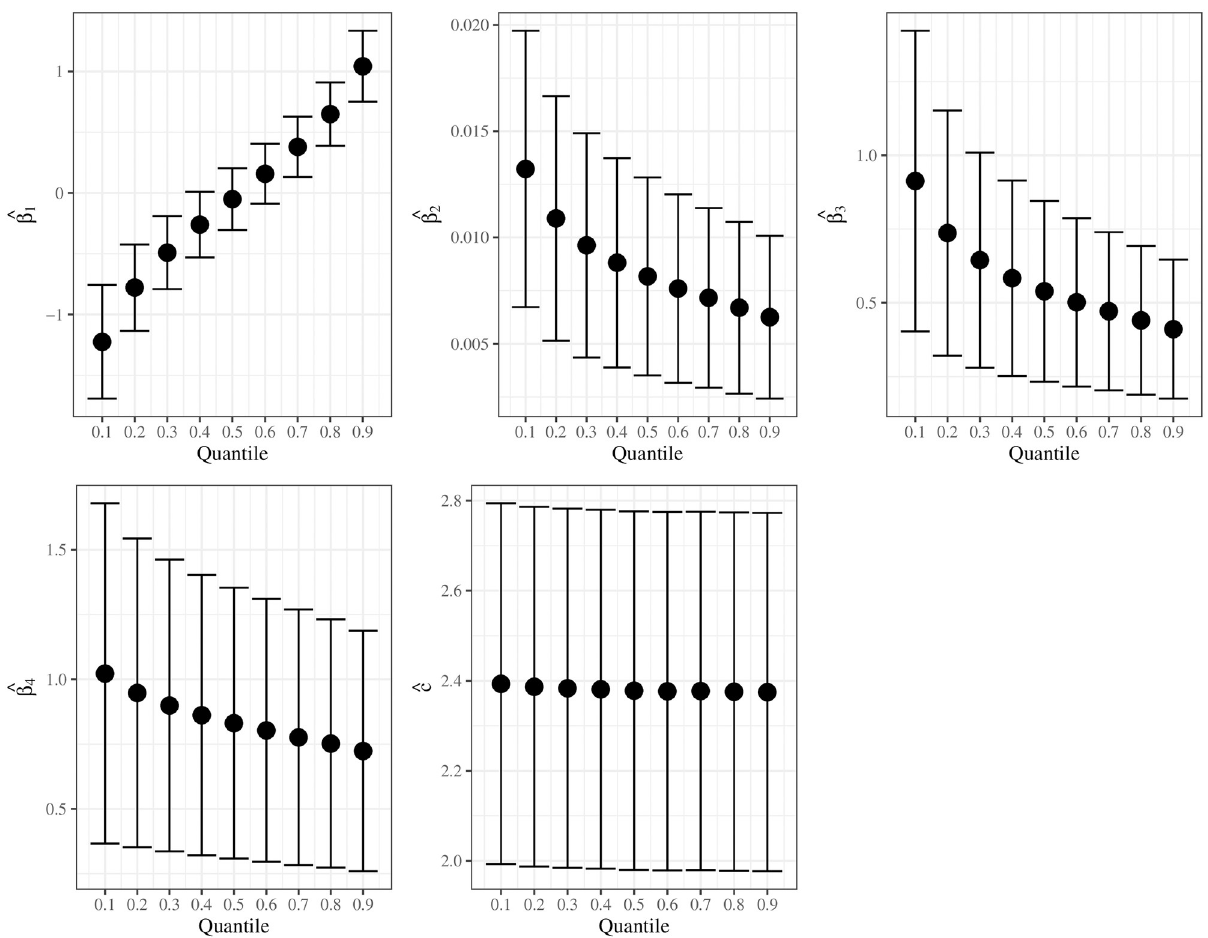
Fig 9. Parameter estimates and the 95% pointwise confidence intervals for the UBXII regression by considering τ 2 {0.1, 0.2, ... , 0.9}.